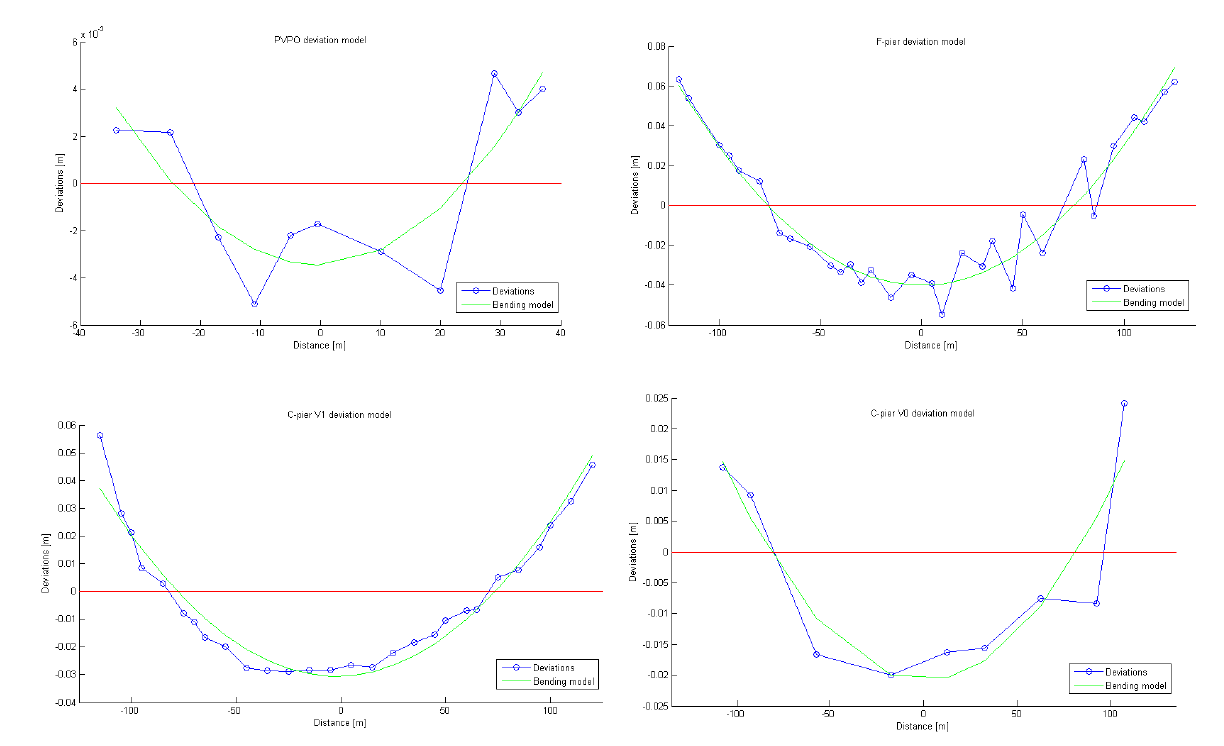
Figure 3: Deviation models relating the errors in Z-direction to the project dimensions. In the following graphics: PVPO (Top Left), F-pier (top right), C-pier V1 (bottom left) and C-pier V0 (bottom right), the blue values represent the mean errors in Z-direction at their respective sections. The green curves represents the best fit quadratic